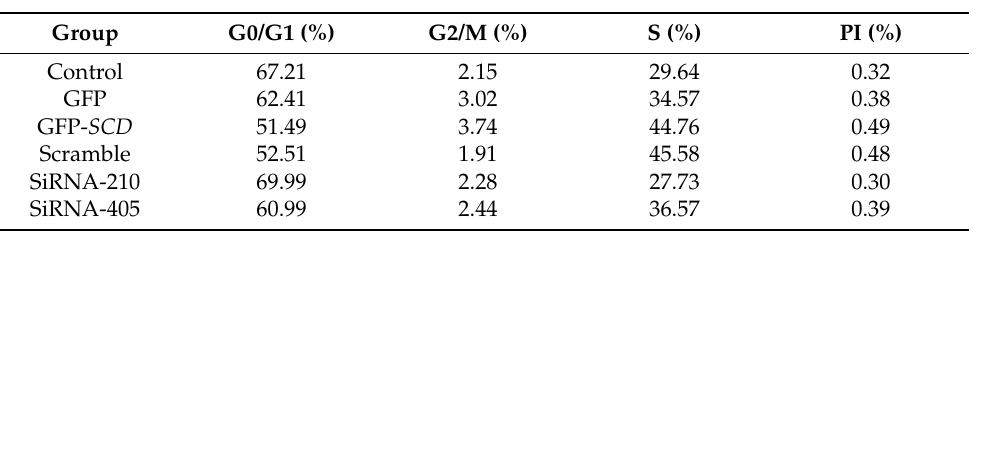
Table 1. Cell cycle results detected by flow